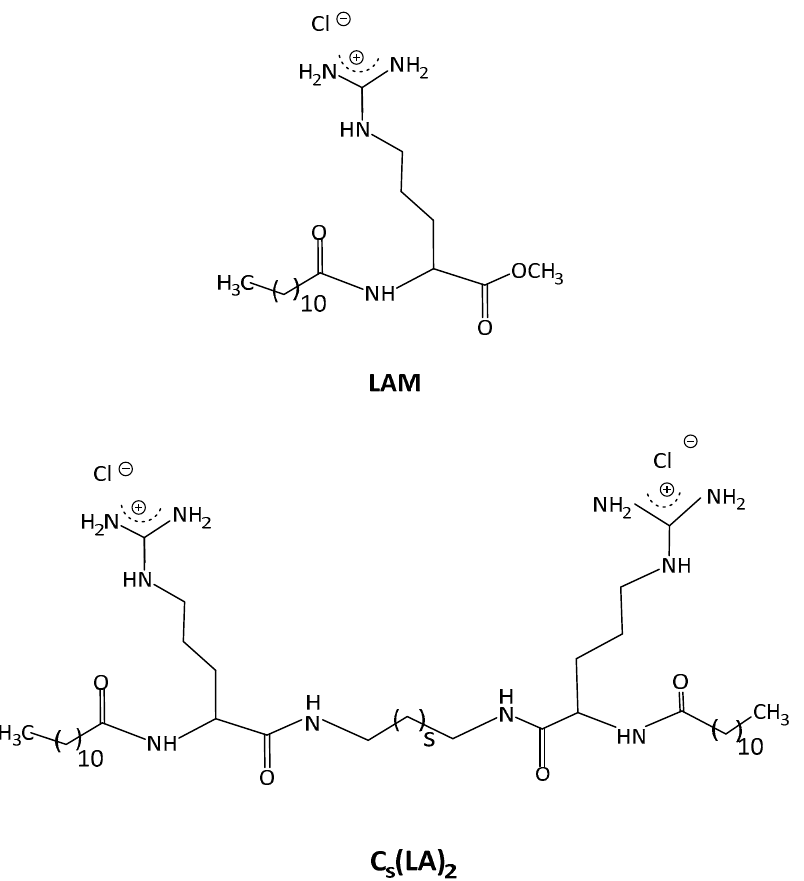
Figure 1. Chemical structure of the arginine-based surfactants. Single chain surfactant, LAM, Gemini surfactants s = 1 C 3 (LA) 2 , s = 4 C 6 (LA) 2 and s = 7 C 9 (LA) 2 .